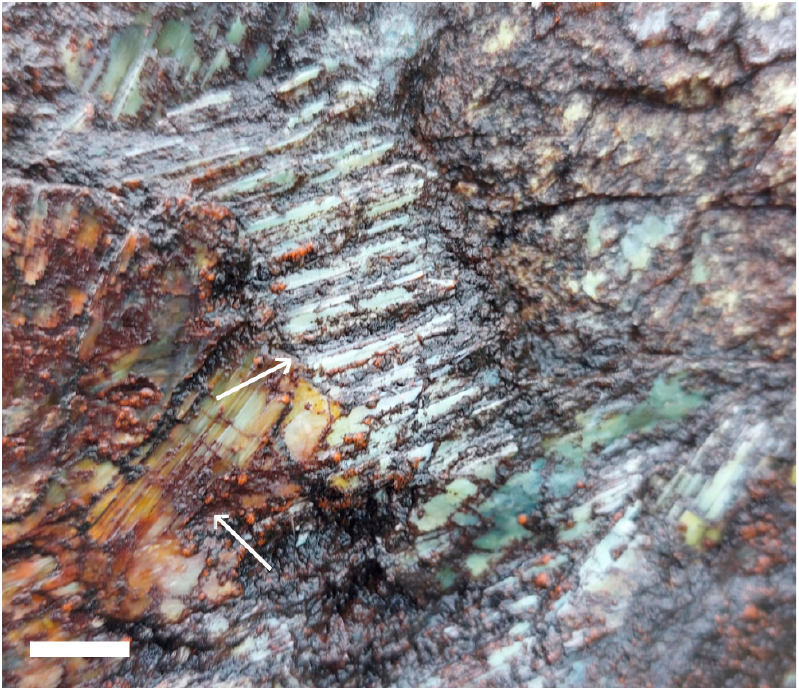
Figure 1. Biofilm on asbestos material, Kahurangi National Park, Nelson, New Zealand. Arrows show areas of biofilm development on asbestos (chrysotile) fibres. Scale bar = 5 mm.